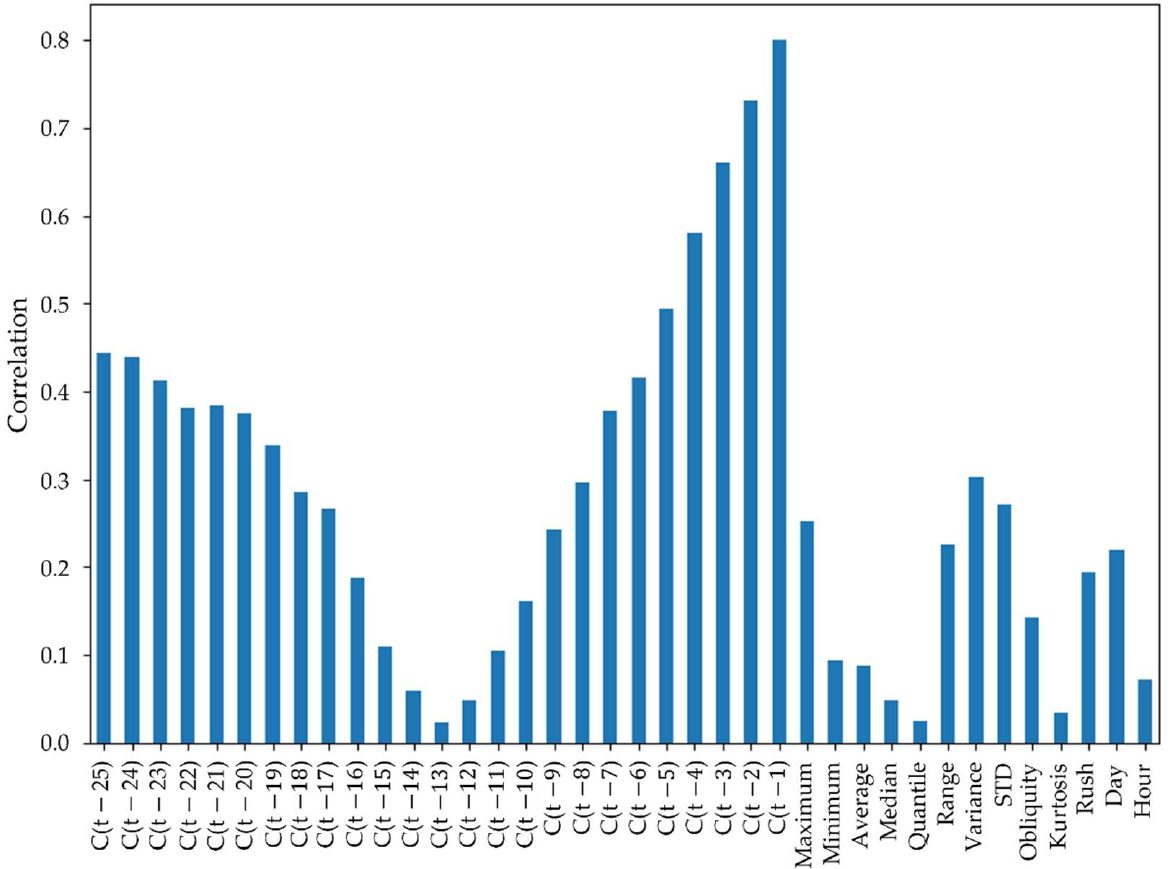
Figure 5. Bar graph of the correction of each feature with the forecast of energy consumption.